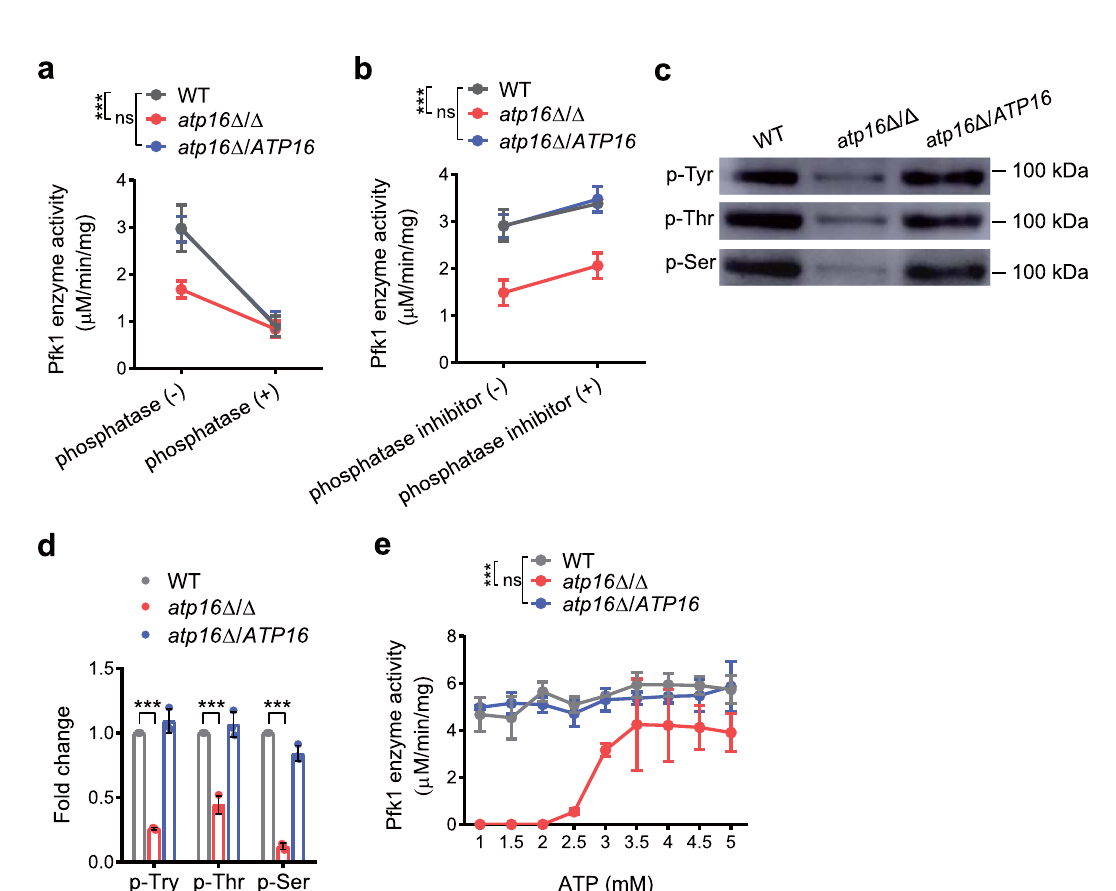
Fig. 5 Deletion of the δ subunit blocks the FBP-mediated cAMP-PKA pathway. a Relative mRNA expression levels of the genes involved in the cAMP- PKA pathway in WT, atp16 Δ / Δ and atp16 Δ / ATP16 were assessed by RT-qPCR. b PKA activities in WT, atp16 Δ / Δ and atp16 Δ / ATP16 were assayed with colorimetric quantitative determination kits. c Intracellular cAMP concentrations in WT, atp16 Δ / Δ and atp16 Δ / ATP16 (2 × 10 4 CFU) were assayed with a cAMP-Glo ™ Assay kit. d , e Hyphae formation of WT, atp16 Δ / Δ and atp16 Δ / ATP16 in the presence of exogenous cAMP (0, 1, 5, 10 mM) ( d ) or 3-isobutyl- 1-methylxanthine (IBMX) (0, 0.01, 0.05, 0.1 mM) ( e ) in Spider medium after incubation at 37 °C for 3.5 h. f Intracellular FBP concentration per mg protein in WT, atp16 Δ / Δ and atp16 Δ / ATP16 . g Hyphae formation of WT and atp16 Δ / Δ in the presence of exogenous FBP (0, 5, 10, 20 mM) in Spider medium after incubation at 37 °C for 3.5 h. h Intracellular cAMP concentrations of WT, atp16 Δ / Δ and atp16 Δ / ATP16 (2 × 10 4 CFU) in the absence ( − ) or presence ( + ) of FBP (20 μ M). i GTP-Ras1 levels before and 3 min after the addition of different concentrations of FBP (0, 5, 20 mM) to permeabilized spheroplasts of atp16 Δ / Δ . GAPDH was used as a loading control. j Intracellular cAMP concentrations of WT (SN250) and ras1 Δ / Δ (2 × 10 4 CFU) in the absence ( − ) or independent experiments. In d , e , g and i one representative experiment out of three independent experiments is shown. * P < 0.05, ** P < 0.01, *** P < 0.001;